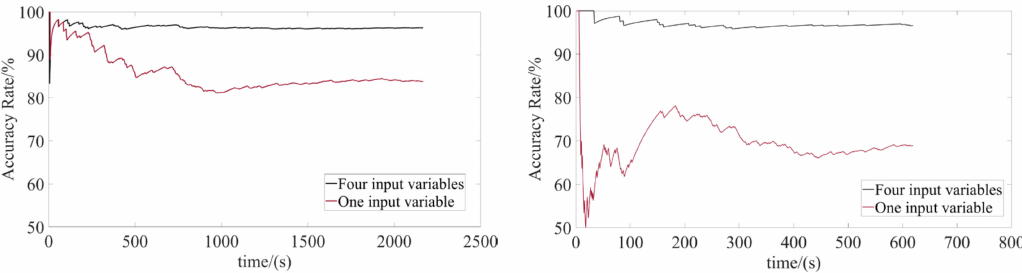
Figure 6. Identification results under simulation (( left ): less aggressive, ( right ): aggressive). TP , FP are the number of samples with correct and incorrect identification results, respectively.